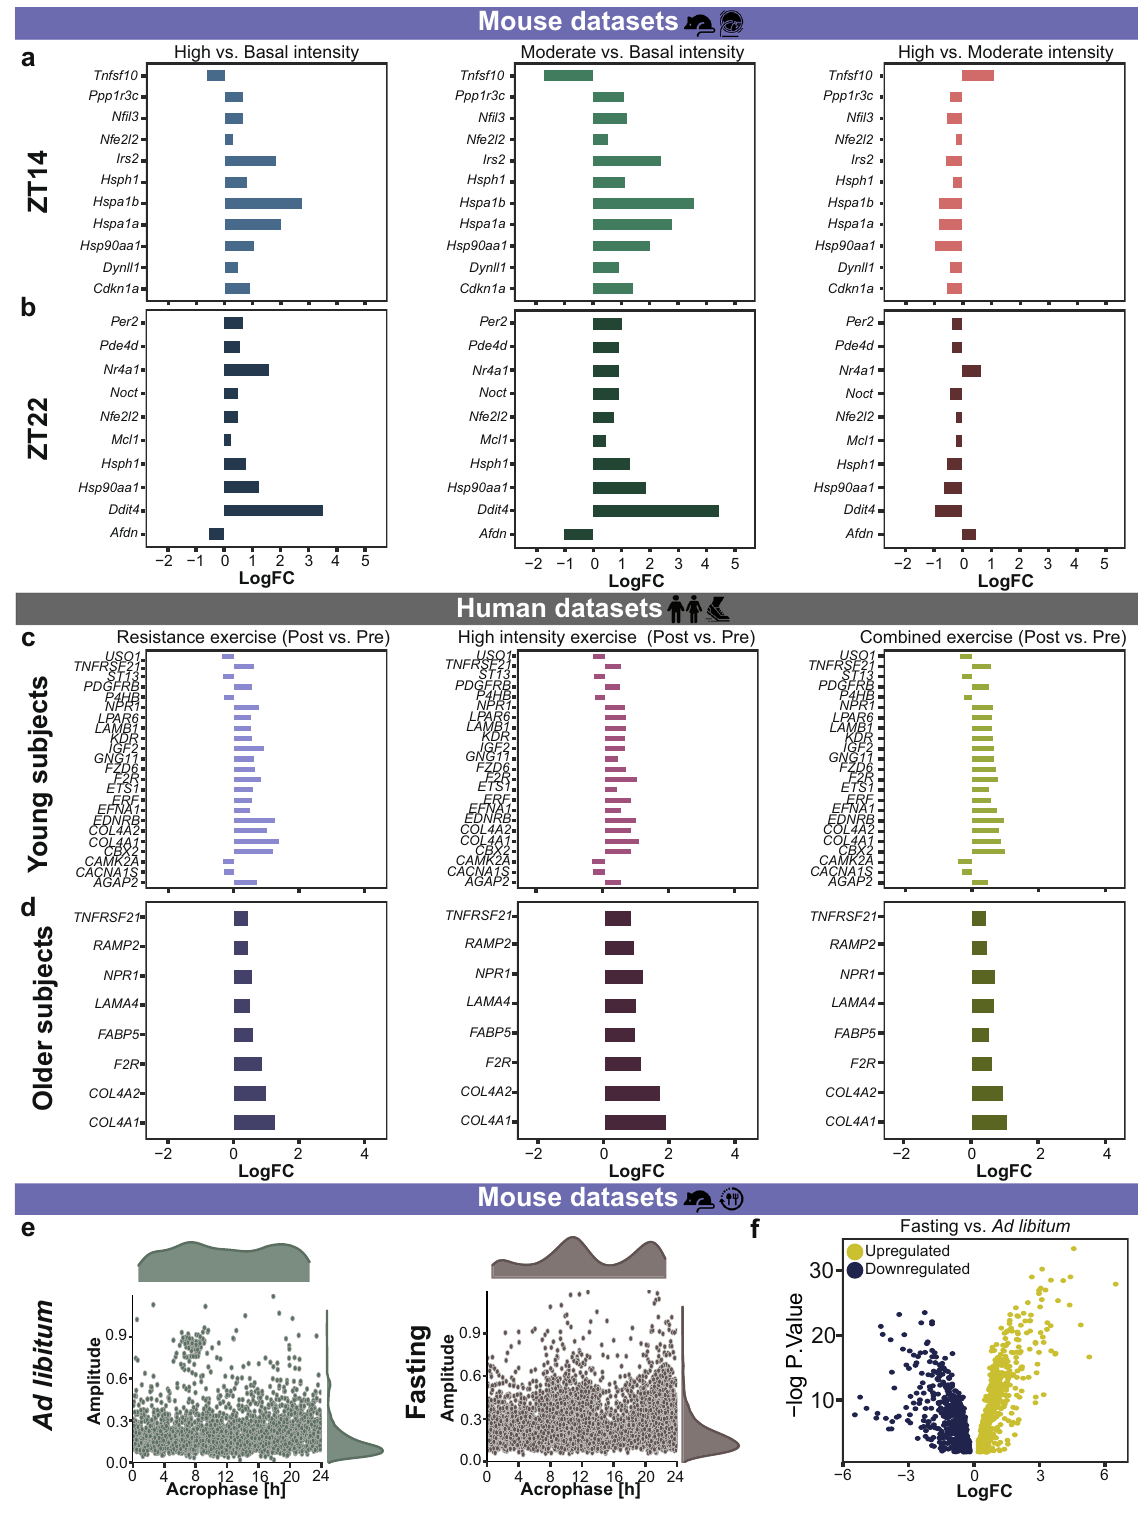
Fig. 6 Extrinsic Zeitgebers like exercise timing and intensity, and fasting affect differential expression of clock- and muscle-related genes in mammalian skeletal muscle tissue. Histogram plot depicts the common differentially expressed genes independent of exercise intensity ( a ) at ZT14 and ( b ) at ZT22 in mouse skeletal muscle, ( c ) in young subjects and ( d ) in older subjects. e Scatter plot represents the circadian properties (amplitude, acrophase) of ~24 h genes after ad libitum and fasting. f Volcano plot represents signi fi cantly up- or down-regulated genes of interest between ad libitum and fasting